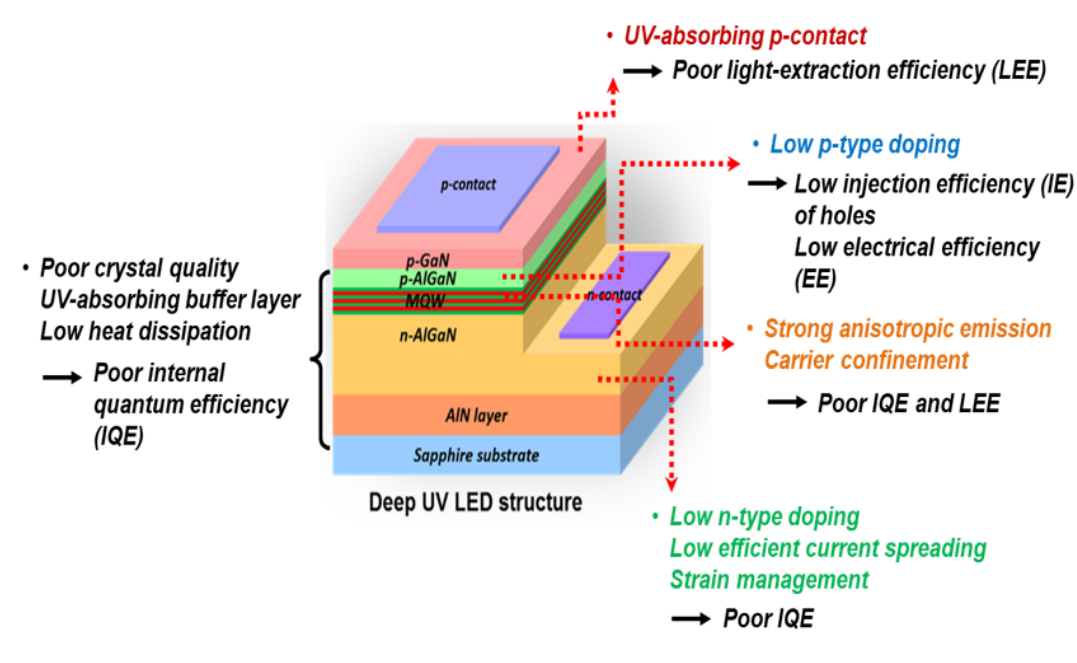
Figure 3. Bottlenecks of DUV-LED chip [16].